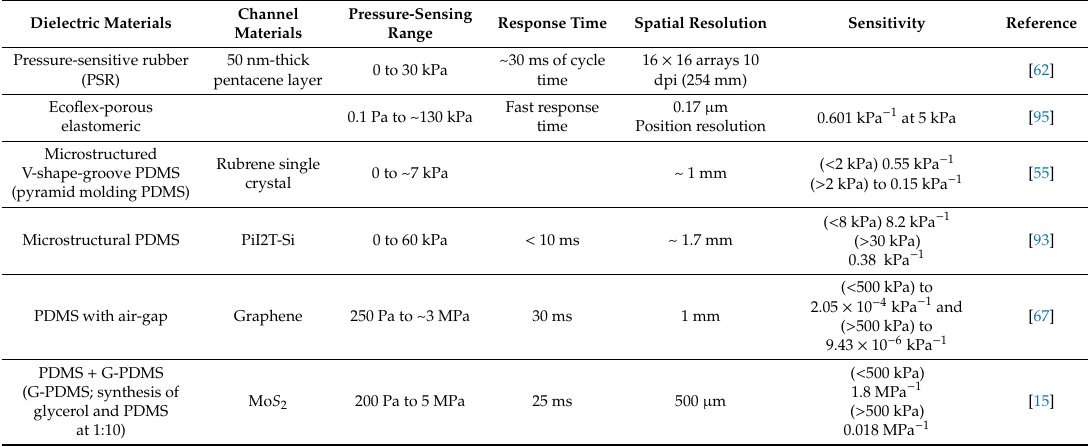
Table 2. The tactile sensor characteristics with various gate dielectric and channel